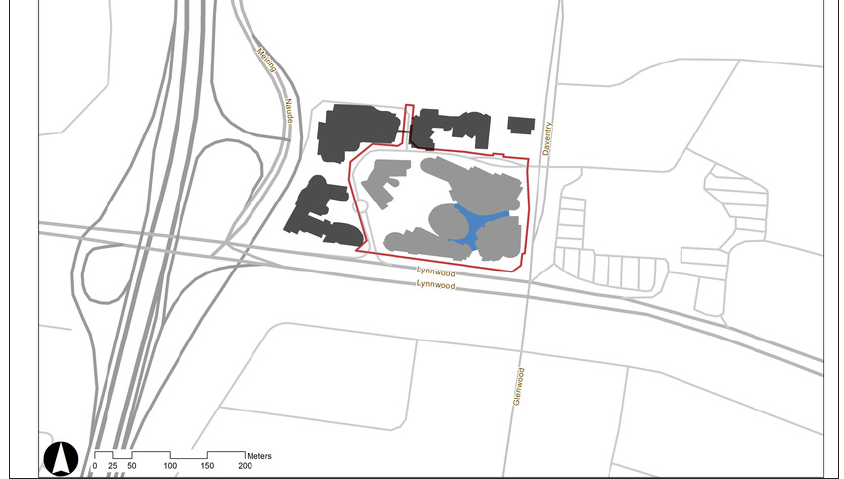
Figure 6: The form and location of the quasi-public space in Lynnwood Bridge Source: Produced by Darren Nel, 2016